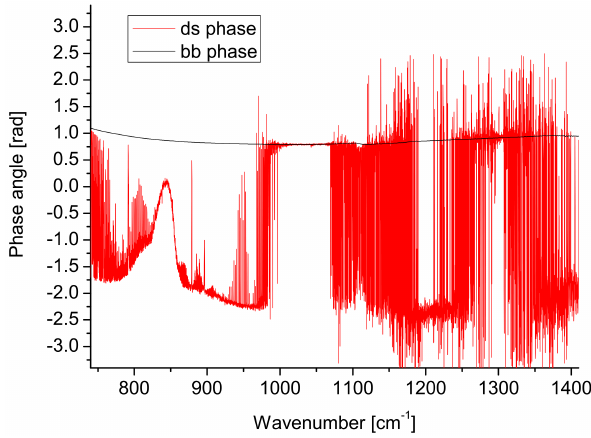
Figure 12. Phase calculated from a complex blackbody spectrum (black) and from a complex deep space spectrum